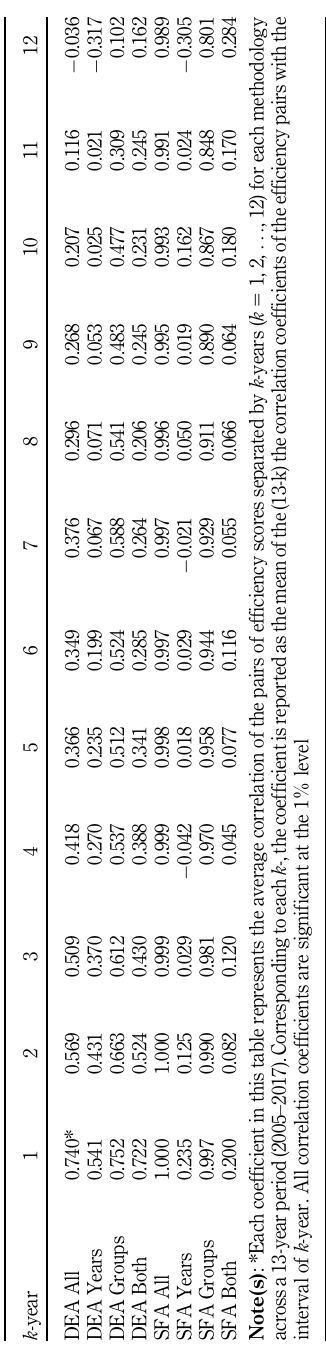
Table 8. The stability of efficiency across k -year